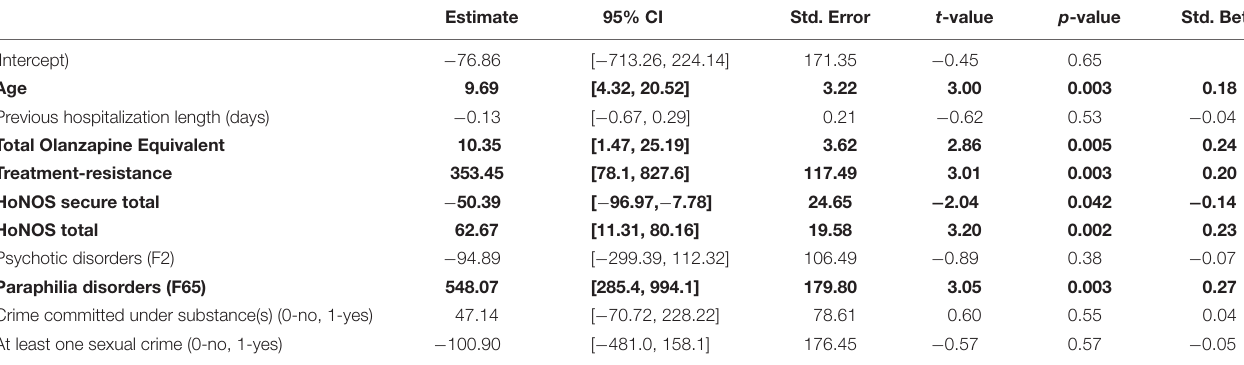
TABLE 1 | Factors increasing or decreasing the length of stay.